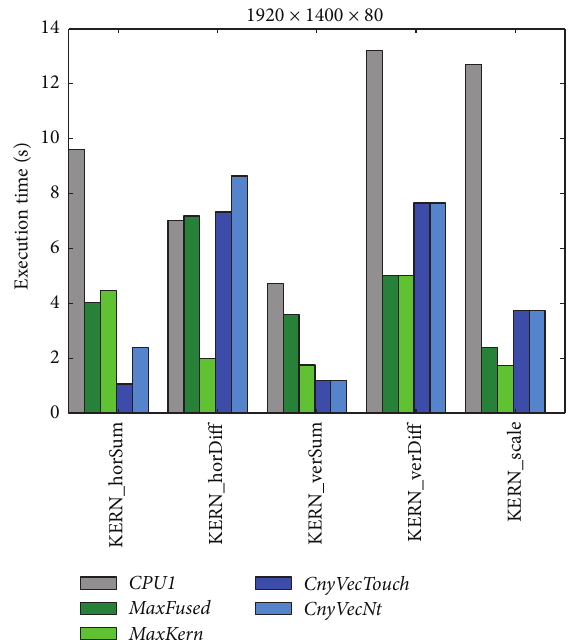
Figure 18: Execution times of individual aggregation